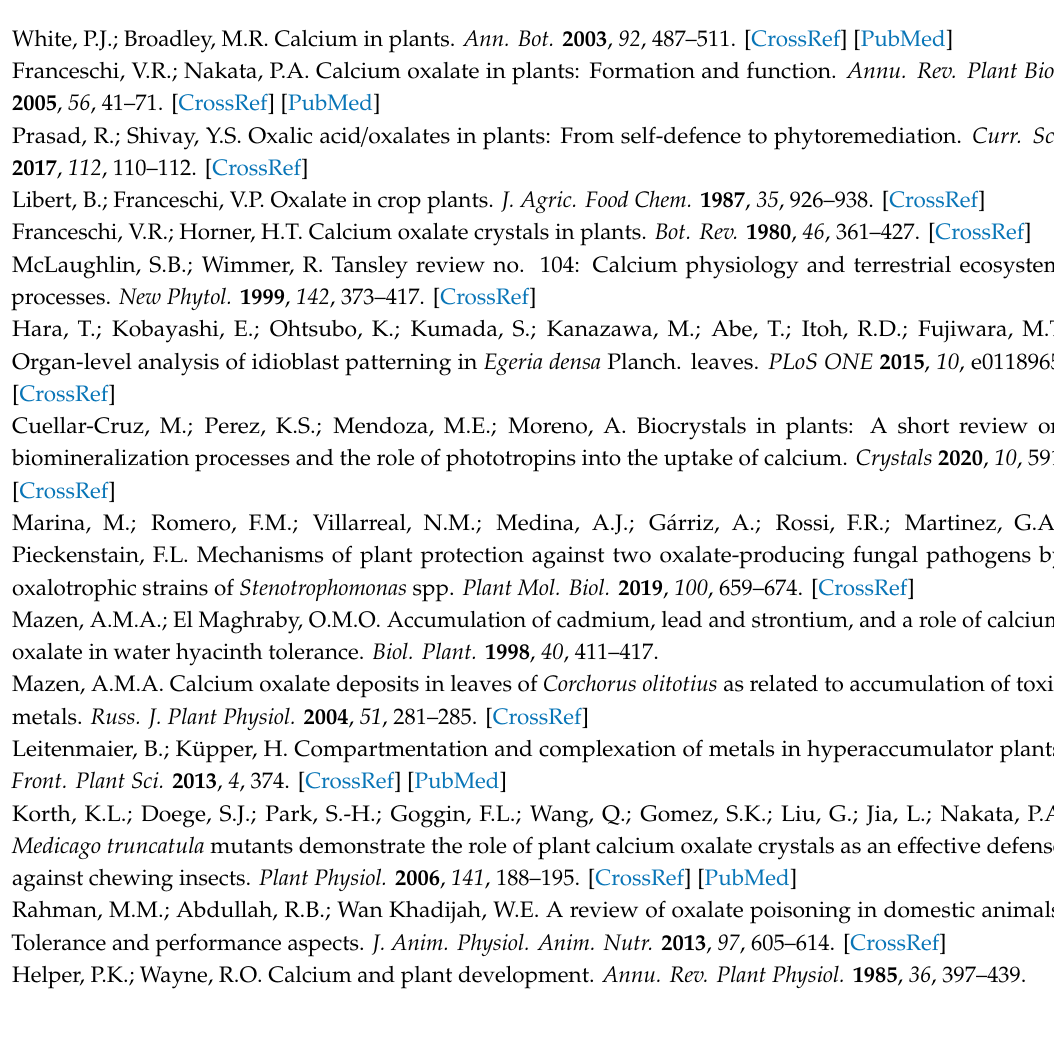
Figure S1: Structure of anther tissues in cross sections from tomato plants. Fragments of anthers with pollen sac (ps) of WT (a) and transgenic (b) plants, and cells of the forming crystal-bearing tissue. Fragments of an opening anther at the stage of the pollen formation completion, and changes in the morphology of ridges at the border of the stomium (c—WT, d—transgenic plants). Anther fragments at the stage preceding dehiscence (e—WT, f—transgenic plants), Figure S2: Structure (transmission transmission microscopy) of calcium oxalate crystals in tomato cells (top row shows a cell fragment, the row below shows an enlarged fragment containing